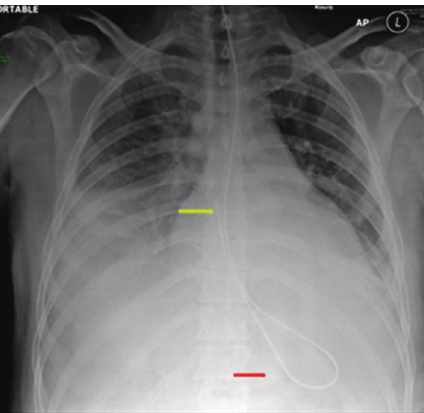
Figure 32: The NGT has formed a loop (red arrow) in the stomach and re-entered the mid/lower esophagus (yellow arrow). This complication may cause reflex in a supine patient and aspiration as in this patient.